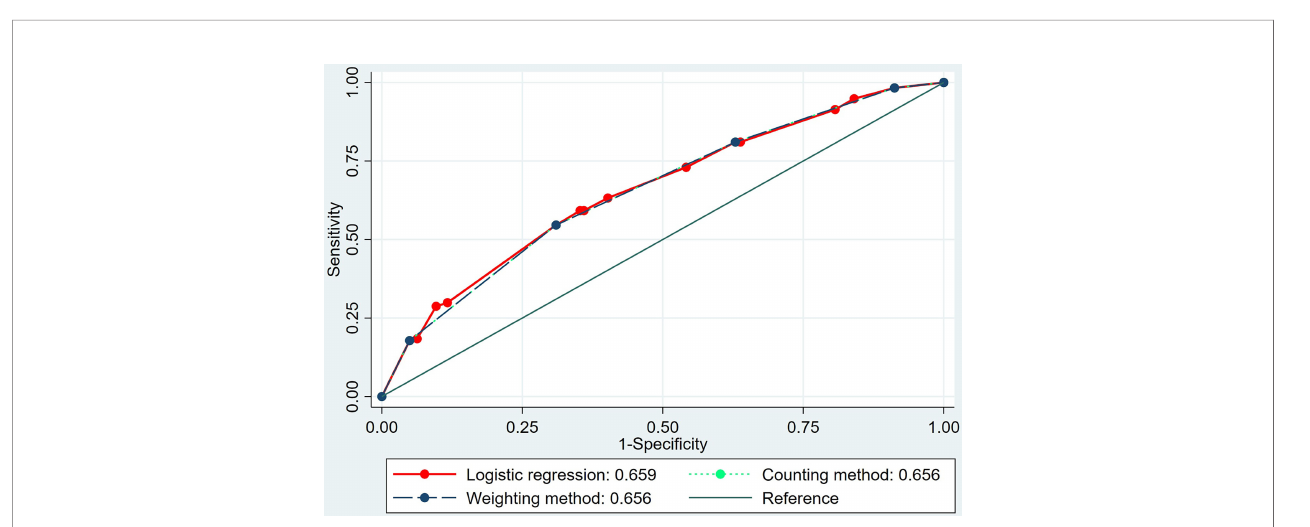
FIGURE 2 | The area under the receiver operating characteristic (ROC) curves of the logistic regression equation, the weighting method, and the counting method in predicting axillary lymph node metastasis of invasive breast cancer.